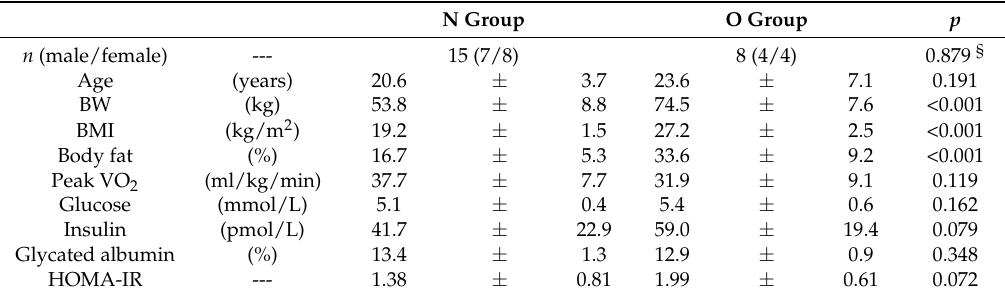
Table 1. Clinical characteristics of the